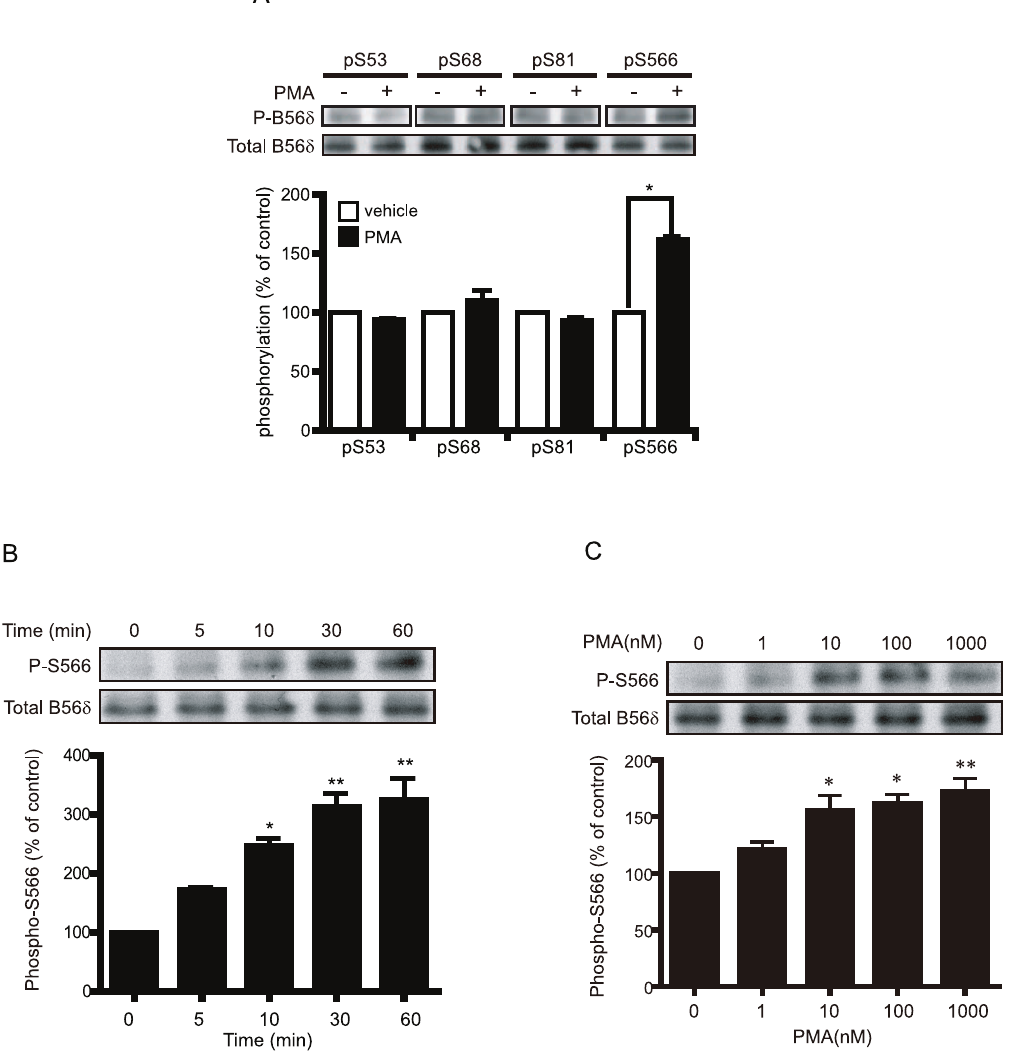
Figure 1. The PKC activator PMA increases phosphorylation of B56 d at Ser566. (A) N2a cells expressing FLAG-B56 d subunit were treated with DMSO (vehicle) or PMA (5 nM) for 5 min. Cells were lysed and proteins were analyzed by SDS-PAGE and immunoblotting with phospho-specific antibodies to the indicated sites in B56 d . Total B56 d was analyzed with anti-FLAG antibody. Upper panels show immunoblots. The bar graph shows quantification of immunoblot data normalized in each experiment to vehicle for each site as means 6 s.e.m. (n=3). *, P , 0.001 compared with vehicle-treated control by student’s t-test. (B) N2a cells expressing FLAG-B56 d were treated with different concentrations of PMA (0, 1, 10, 100, 1000 nM) for 5 min. Phosphorylation of Ser566 and total B56 d was assayed as in (A). The bar graph shows quantification of data normalized in each experiment to the zero PMA condition as means 6 s.e.m. (n=3). *, P , 0.05, **, P , 0.01 compared with vehicle-treated control by student’s t-test. (C) N2a cells expressing FLAG-B56 d were treated with 5 nM PMA for the indicated times. Phosphorylation of Ser566 and total B56 d was assayed as in